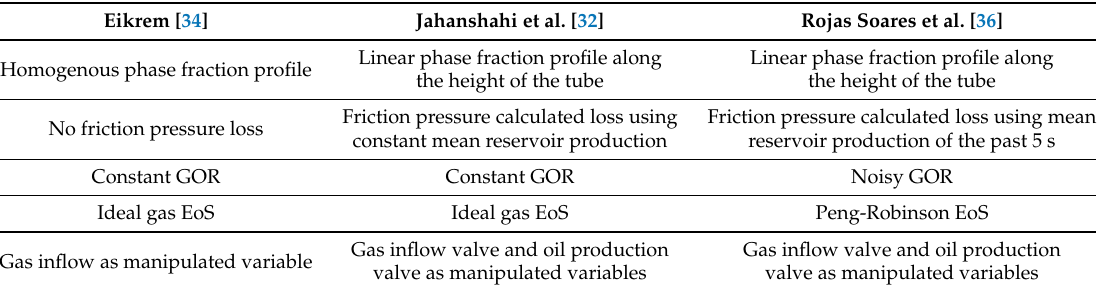
Table 1. Particular characteristics of the